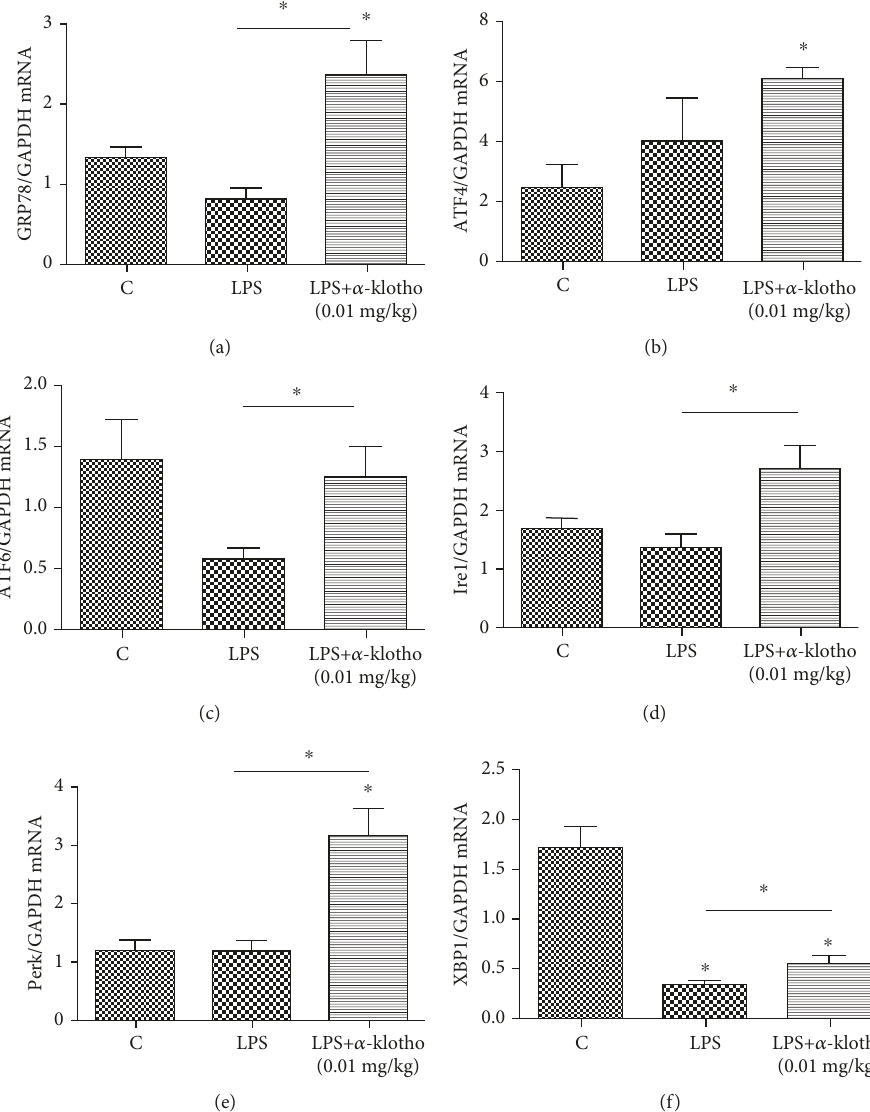
Figure 7: α -Klotho elevated the mRNA expression of ER stress-related proteins in LPS-stimulated mouse heart (a – f). Heart tissues were collected at 24 h after LPS injection in the control group ( n = 6 ), LPS group ( n = 6 ), and LPS+ α -klotho (0.01 mg/kg) group ( n = 6 ). The mRNA expressions of GRP78 (a), ATF4 (b), ATF6 (c), Ire1 (d), Perk (e), and XBP1 (f) were measured at 24 h after LPS injection by real- time PCR. ∗ p < 0 05